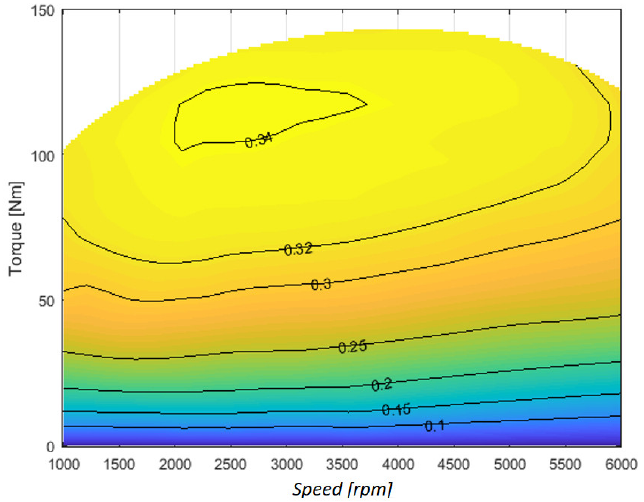
Figure 4. ICE efficiency contour map.